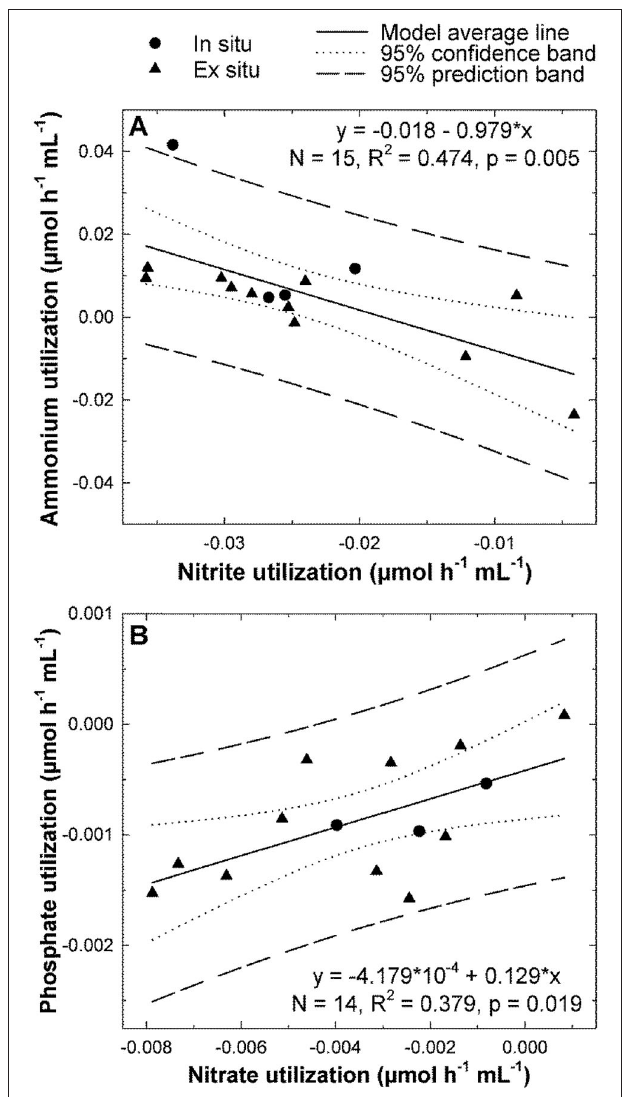
FIGURE 4 | Significant relationships between nutrient fluxes in Vazella pourtalesii . (A) The lower the rate of nitrite release, the higher the ammonium consumption. (B) When individual #2, an atypical outlier consuming nitrate at the abnormally high rate of 17 nmol mL − 1 h − 1 —rather than releasing it–, was excluded from the analysis, a linear significant relationship was revealed between the release rates of nitrate and phosphate. The rest of possible pairwise combinations among the flux rates of all four nutrients were also examined, but none had statistically significant support.